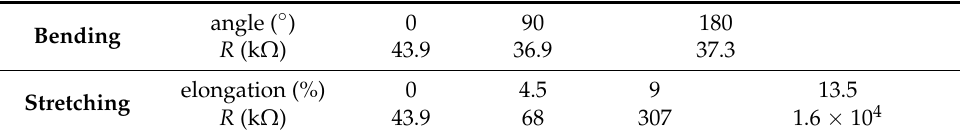
Table 4. Resistance of a 15 wt% RTV/GNP composite route with length of 110 mm and width of 2 mm during bending and stretching as shown in Figure